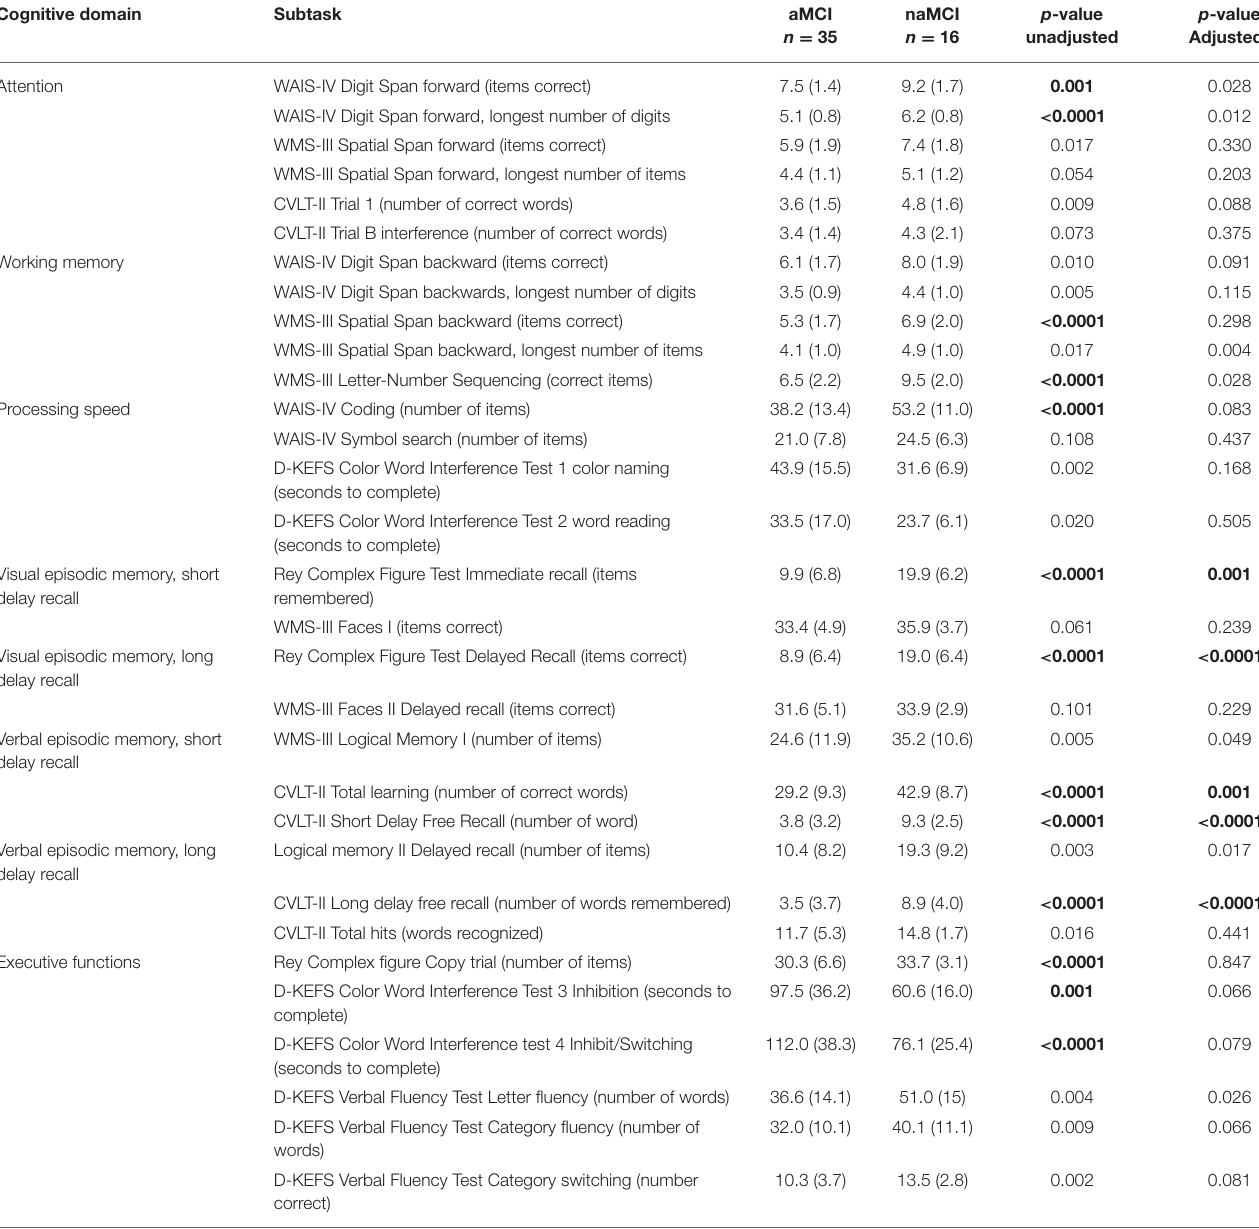
TABLE 6 | Neuropsychological test results in patients with amnestic MCI (aMCI) ( n = 35) and nonamnestic MCI (naMCI) ( n = 16). Cognitive domain Subtask